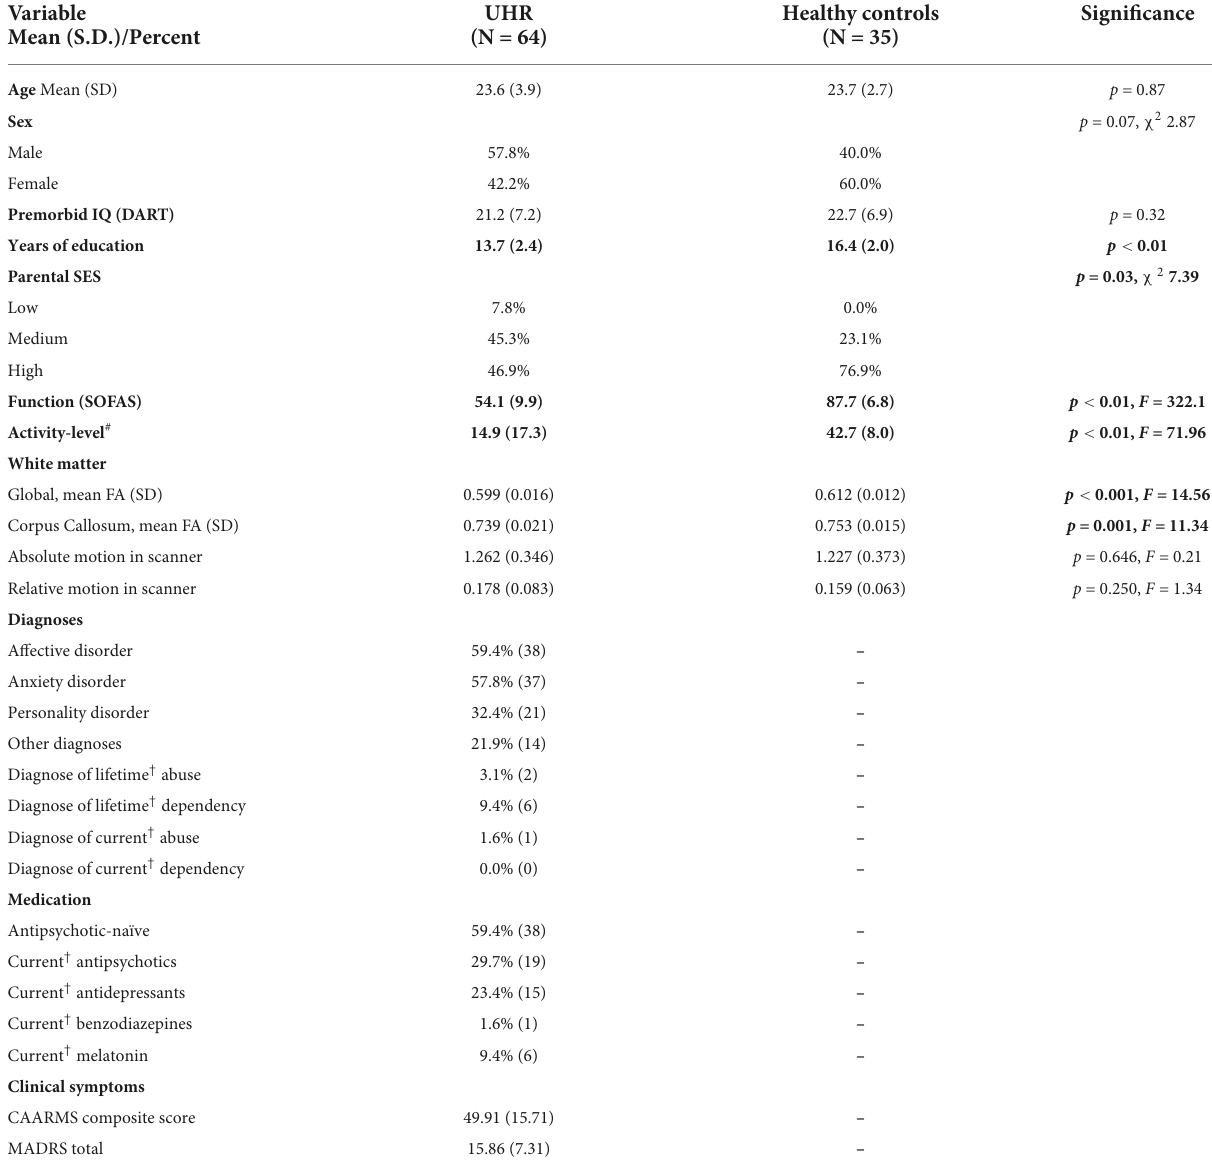
TABLE 1 Sociodemographic and clinical data at baseline for individuals at ultra-high risk and healthy controls. Variable Mean